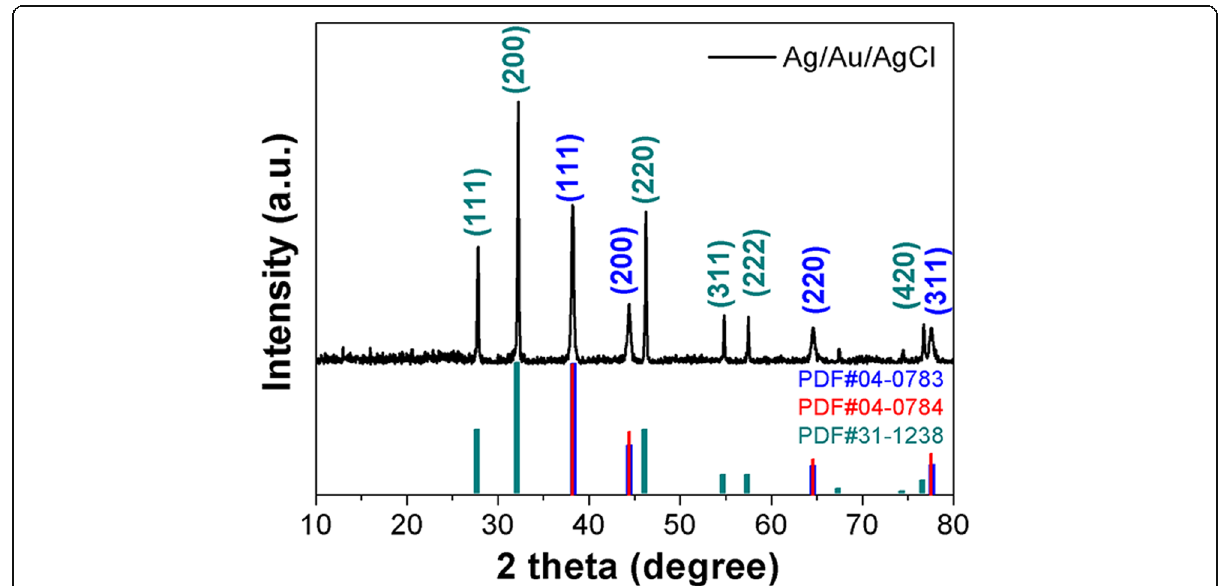
Fig. 3 The XRD pattern of as-synthesized Ag/Au/AgCl hollow heterostructure (S1), the standard JCPDS cards of Ag (04 − 0783, blue column), Au (04 − 0784, red column), and AgCl (31 − 1238, green column) are carried out for comparison